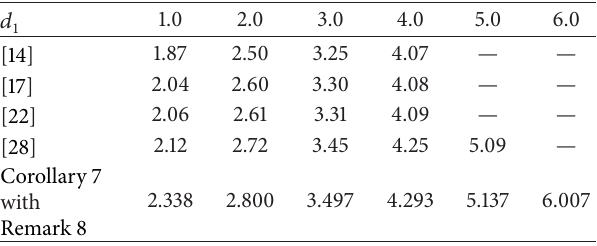
Table 4: Admissible upper bounds 𝑑 2 with unknown 𝜇 and 𝑑 1